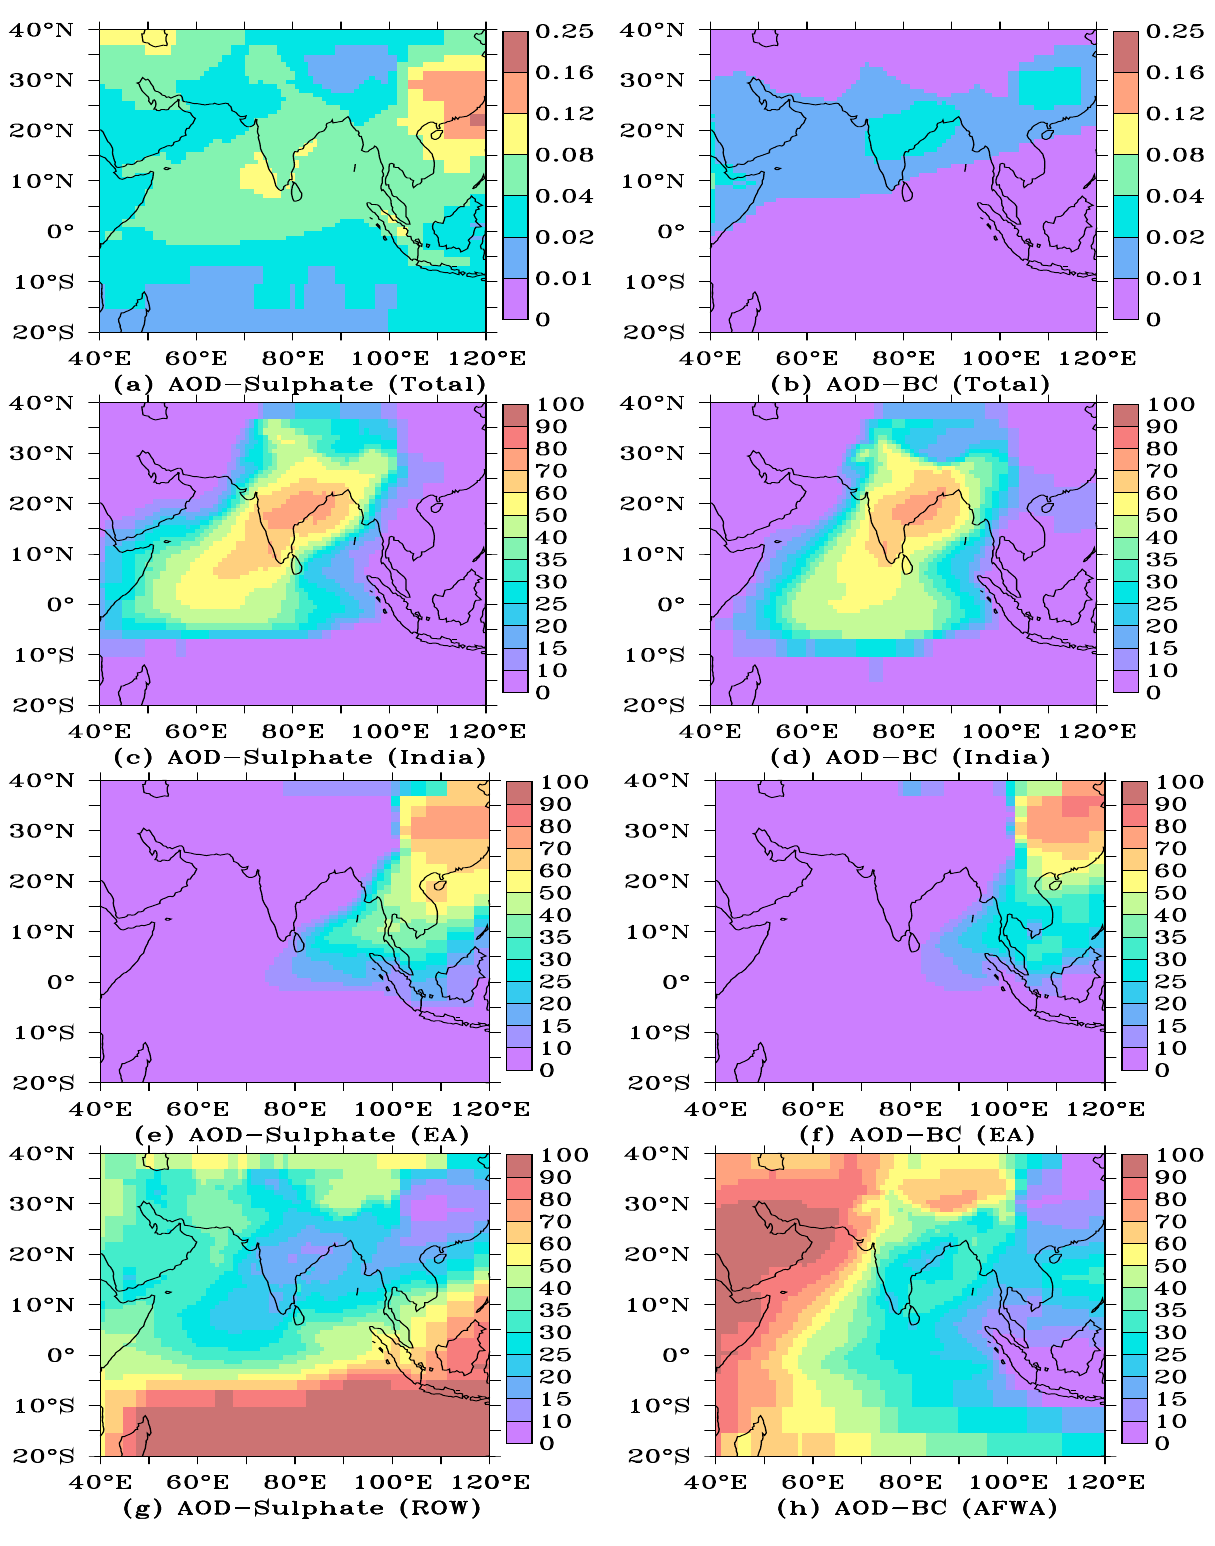
Fig. 32. Aerosol optical depth (AOD) at 550nm simulated with the LMD-ZT GCM for sulphate and BC aerosols: (a) and (b) total; (c) and (d) from India; (e) and (f) from East Asia; (g) sulphate from the rest off the world (not including Africa); (h) BC from Africa and Arabia (from Verma et al., 2008, copyright 2008 by the American Geophysical Union, reproduced with permission).